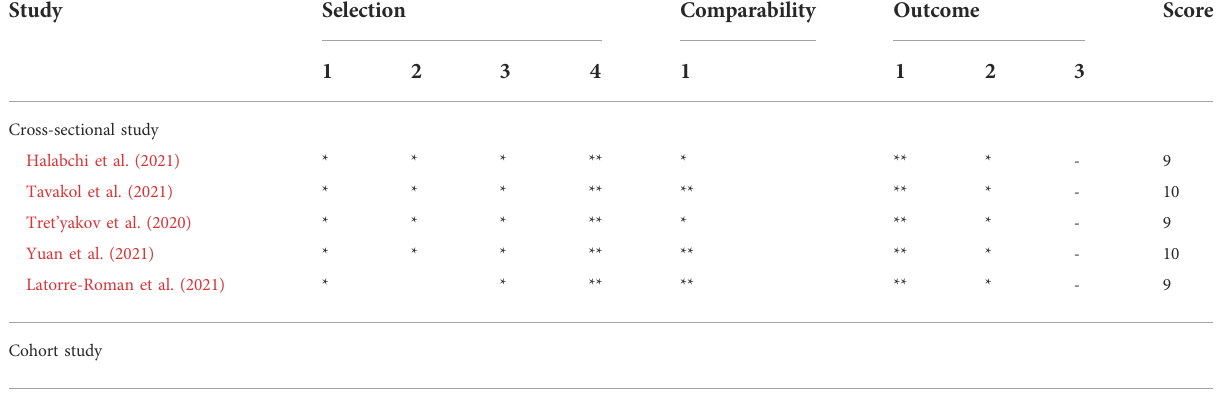
TABLE 2 Assessment of quality using the Newcastle-Ottawa